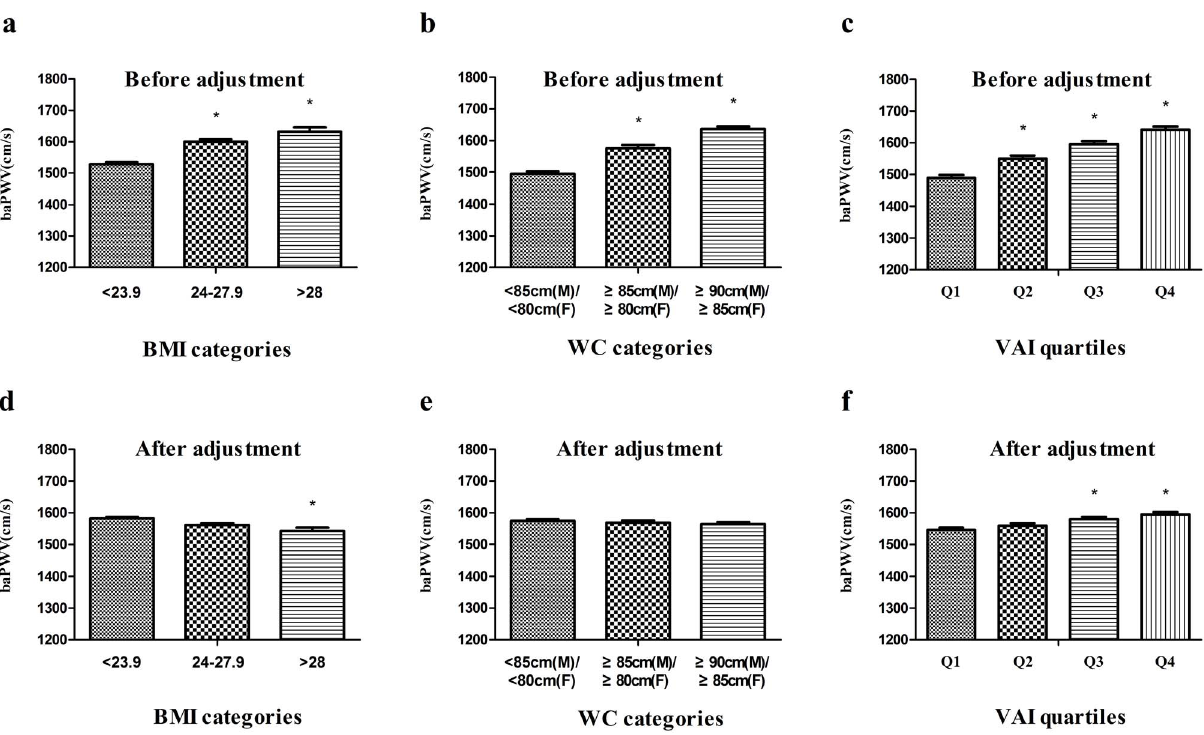
Figure 1. Relationship between obesity category (based on BMI, waist circumference and visceral adiposity index) and brachial- ankle pulse wave velocity (mean ± s.e.). a, b, c: Before adjustments. d, e: After adjustments for systolic blood pressure (SBP), age, heart rate, 120- min post-OGTT plasma glucose (PG120) and lipids. f: After adjustments for SBP, age, heart rate, PG120, low-density lipoprotein cholesterol and cholesterol. * P , 0.01 for the comparison to the first category or first visceral adiposity index quartile.